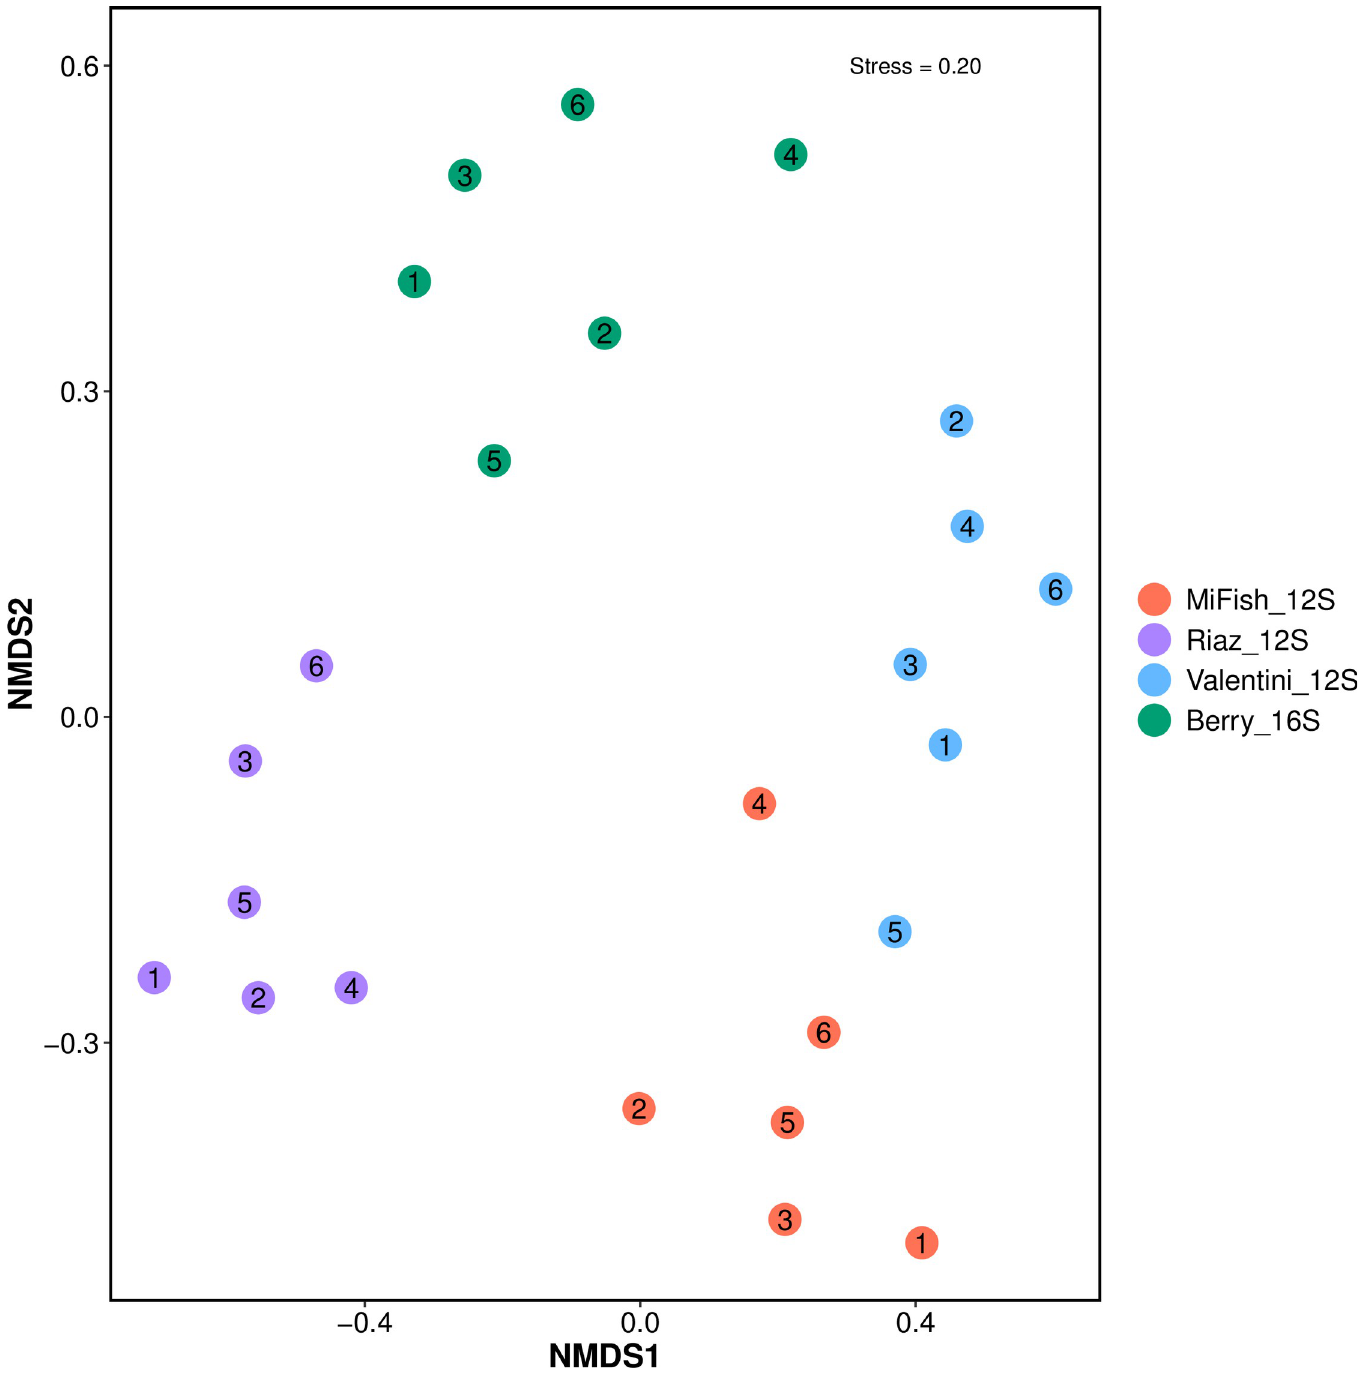
Fig 3. Nonmetric multidimensional scaling plots (NMDS) based on read abundance for each of the species detected from six sampling locations in the Indian River Lagoon, Florida. The numbers inside the circles represent sample sites. Metabarcoding data was generated for four primer sets designed to amplify fishes. https://doi.org/10.1371/journal.pone.0266720.g003 we combined the three 12S primer sets while combining the Riaz_12S and Berry_16S primers detected 93.4% (71 of 76). This finding supports the importance of not only employing multi- ple primer sets but also using primers that target different genes.